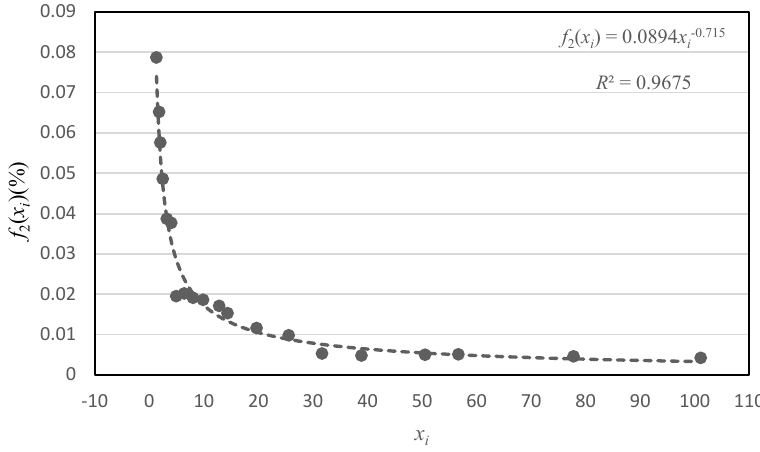
Figure 1. The relationship curve between the particle size ratio and the residual particle volume fraction.